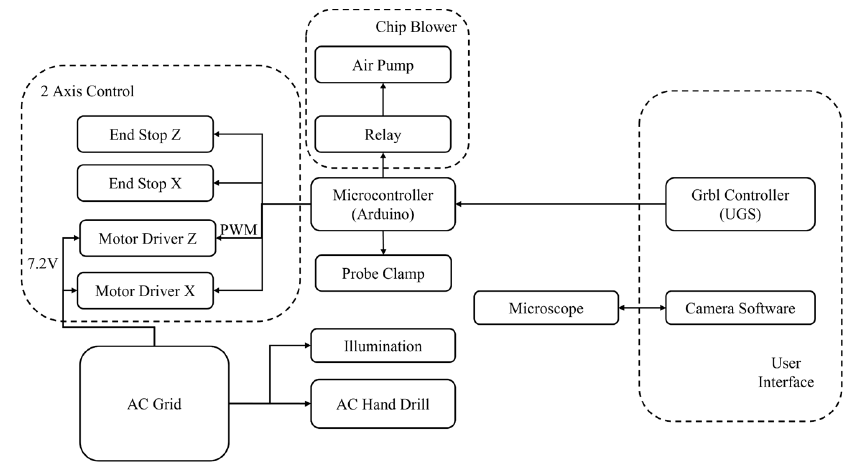
Figure 2. System architecture for the measurement device.